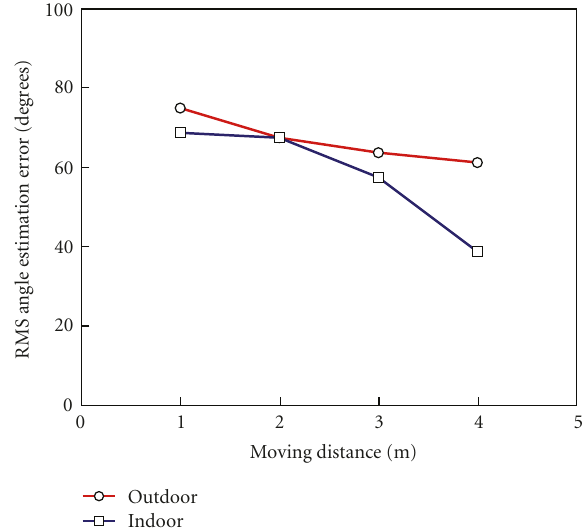
Figure 20: Experimental result on the RMS angle estimation